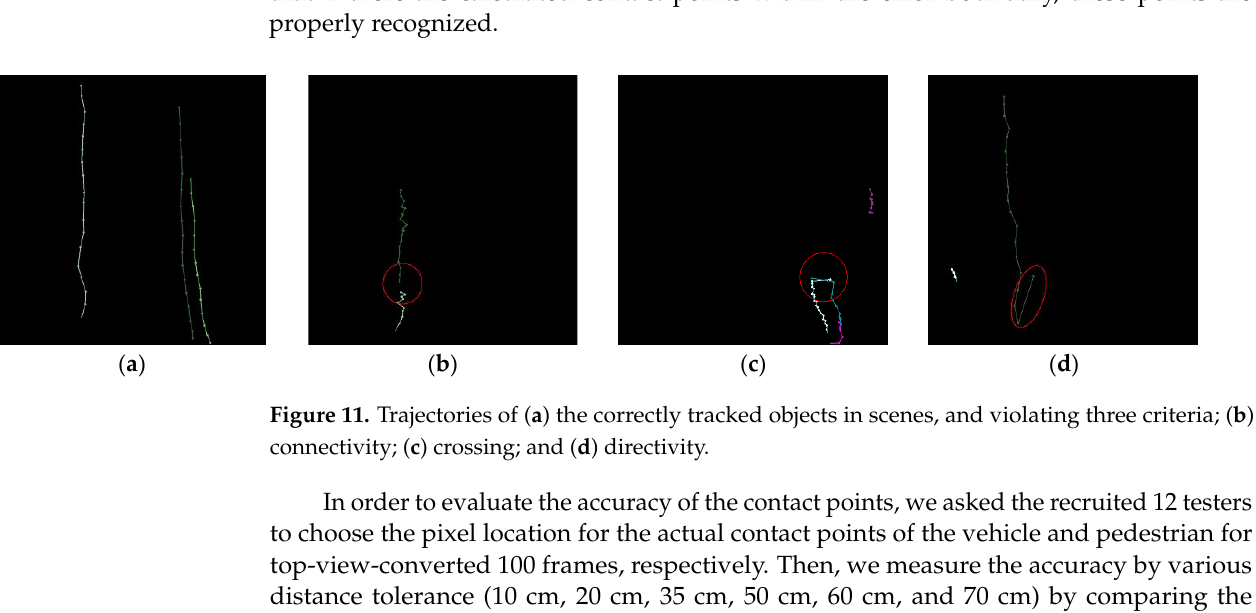
Table 4. Results of trajectory validation based on three criteria.